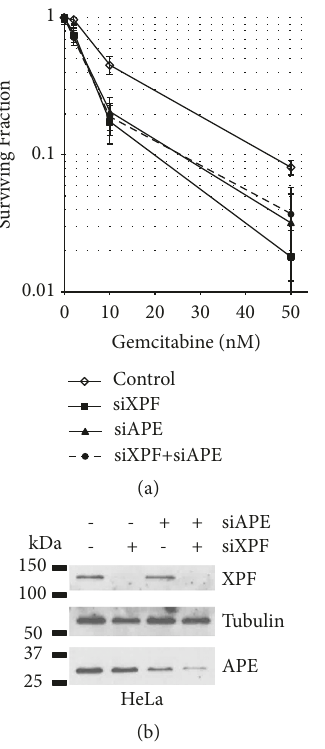
Figure 2: XPF is epistatic to APE in the gemcitabine resistance . The expression of XPF and/or APE was suppressed by siRNAs in HeLa cells and the cellular sensitivity to gemcitabine was examined. XPF- or APE-suppressed HeLa cells (closed square and closed triangle, respectively) showed sensitivity to gemcitabine. Cosuppression of XPF and APE (closed circle with dashed line) resulted in the sensitivity to gemcitabine similar to the sensitivity induced by the suppression of XPF or APE individually. A control siRNA (siCon- trol) was used as a control (open diamond). Three independent experiments were performed and averages of surviving fraction are plotted. The error bars show standard deviations. The differences in the gemcitabine sensitivity between the control cells and the cells treated with siXPF, siAPE, or siXPF+siAPE are statistically significant at 10 nM and 50 nM with p < 0.05. The western blots showed a significant suppression of XPF (more than 95%) and ∼ 75% reduction in the expression of APE with the siRNA treatment. The cosuppression experiments with two siRNAs, siXPF and siAPE, resulted in similar levels of suppression of each protein induced by individual siRNA (more than 95% reduction in XPF and ∼ 85% reduction in APE). Tubulin was used as a protein loading control.